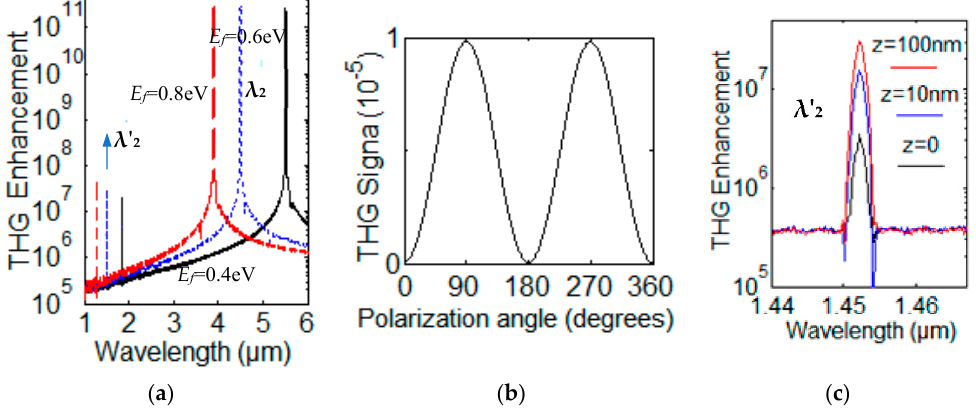
Figure 8. ( a ) Log plot of the THG enhancement factor with three different E f = 0.40 eV (black solid line), 0.60 eV (blue dotted line) and 0.80 eV (red dash line) for FW modes λ 2 . ( b ) Polar diagram of polarization state of the THG emission at λ (cid:48) 2 . ( c ) Log plot of the THG enhancement factor at λ (cid:48) 2 with three different position z = 0, z = 10 nm and z = 100 nm away from the graphene layer, respectively. The polarization state of the THG emission at λ 8 is a function of the angle (not the polarization of the incident field θ = 0) corresponding to the x